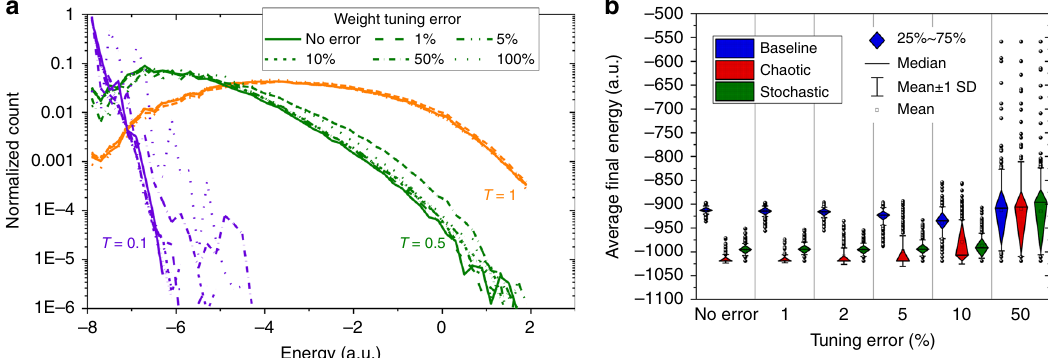
Fig. 5 The impact of weight precision on functional performance. The simulation results for ( a ) energy distribution of RBM on Fig. 2a and ( b ) energies after 80th epoch of graph-partitioning problem of Fig. 3c, obtained with different assumptions for the conductance tuning. For RBM simulations, the data were collected over 500 epochs, and were averaged over 500 different trials. In neurooptimization experiment, 200 sets of weights were generated for each case of tuning error. A single data point on a graph represents an energy achieved after 80 th epoch, averaged over 16 × 10 trials (10 runs for each of the 16 initial states) for a speci fi c set of weights. For clarity, data point inside 25 – 75% are not shown. The tuning error was simulated by choosing randomly weights from the range of target value × [1 − tuning error, 1 + tuning error]. To make the comparison meaningful, the energy is calculated assuming target (error-free) weights in both